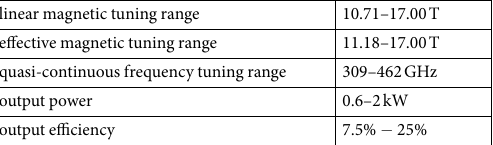
Table 2. Tuning parameters and output parameters in ideal multi-band